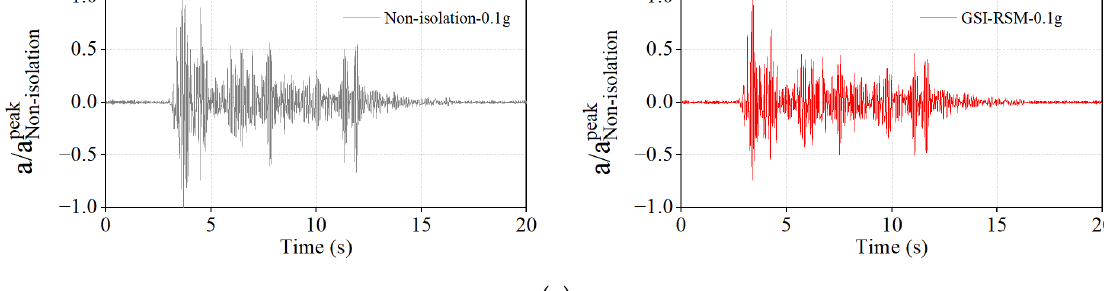
Figure 18. Normalized acceleration time–history curve of structural roof: ( a ) input acceleration am- plitude of 0.1 g; ( b ) input acceleration amplitude of 0.2 g; ( c ) input acceleration amplitude of 0.4 g.